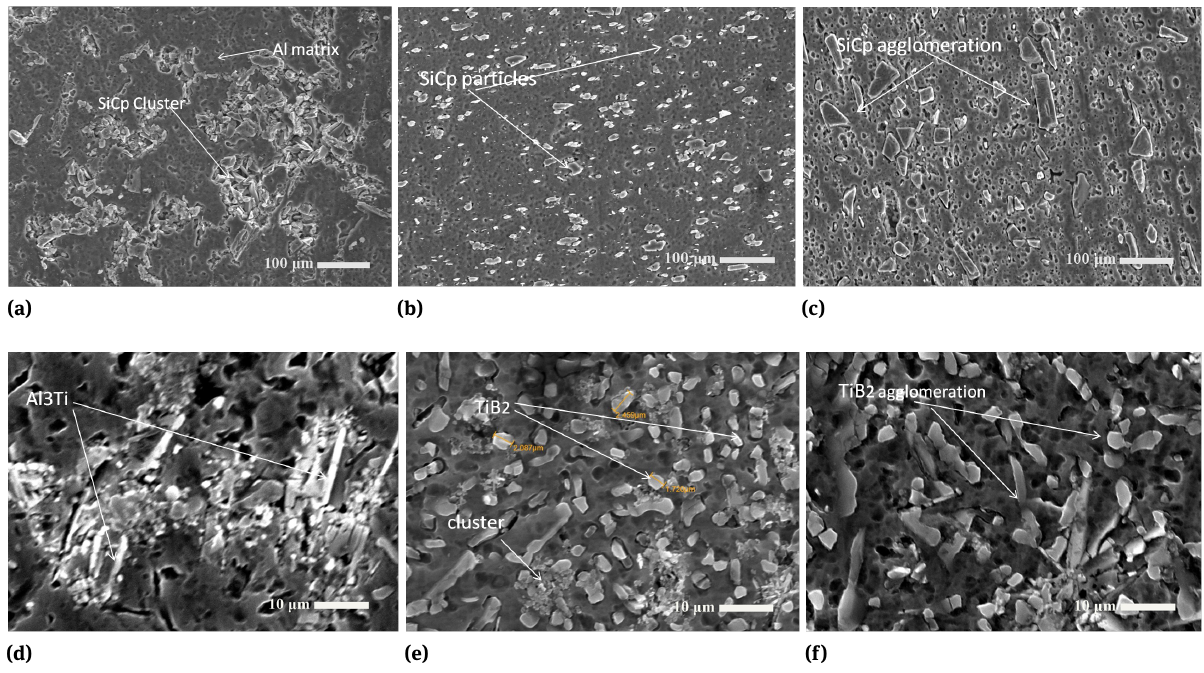
Figure 3: (a) SEM micrograph shows Al/SiCp prepared at 730 ∘ C; (b) SEM micrograph shows Al/SiCp prepared 750 ∘ C; (c) SEM micrograph shows Al/SiCp prepared at 770 ∘ C; (d) SEM micrograph shows Al/TiB2 prepared at 800 ∘ C; (e) SEM micrograph shows Al/TiB2 prepared at 820 ∘ C; (f) SEM micrograph shows Al/TiB2 prepared at 840 ∘